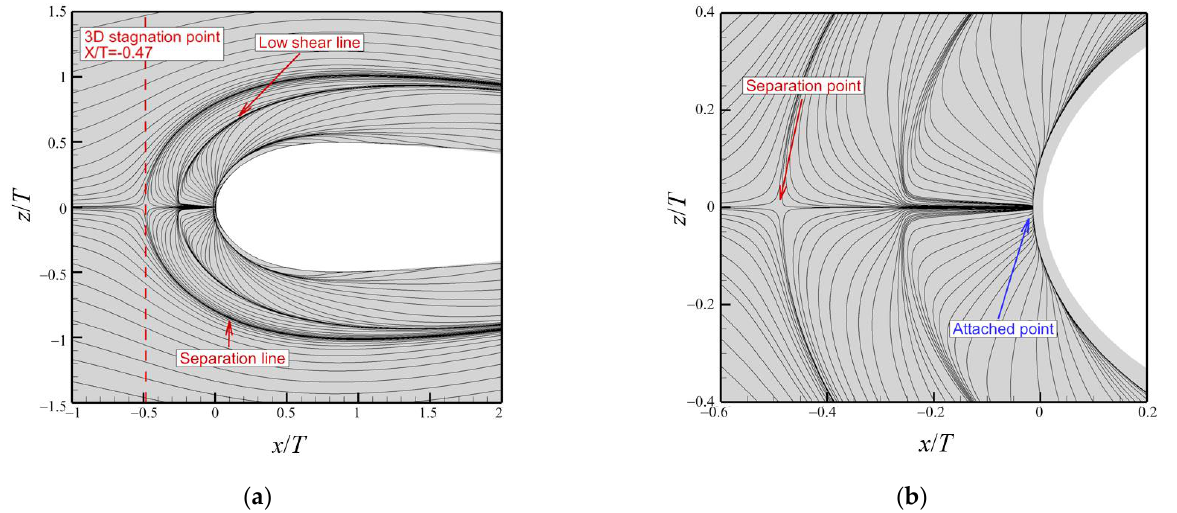
Figure 5. Streamlines at junction nose calculated using SLA-IDDES: ( a ) streamlines; ( b ) two-vortex system.